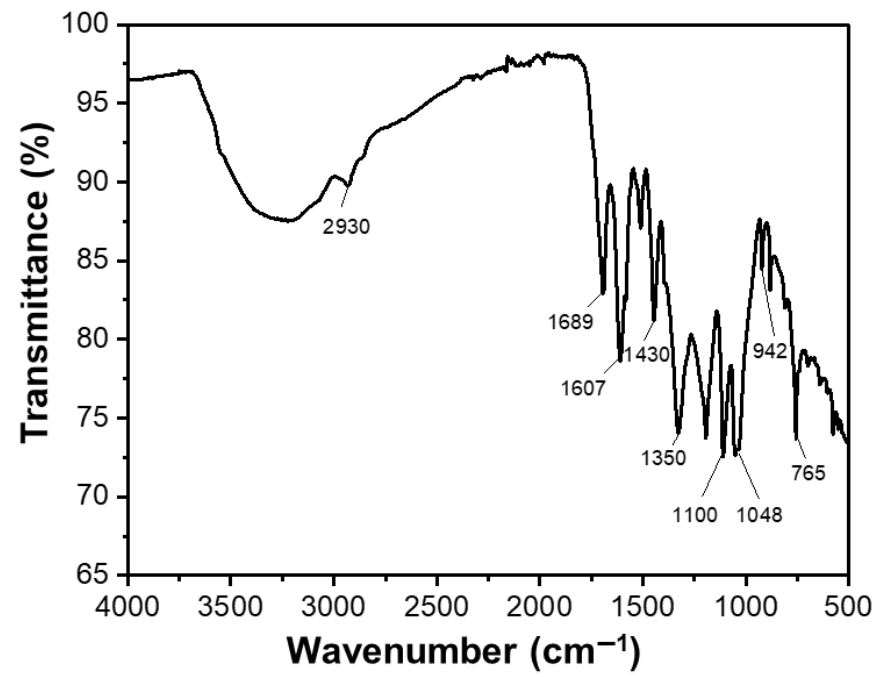
Figure 7. FTIR spectrum of the Se NPs prepared with the Se 4+ /CO volume ratio of 1/2.